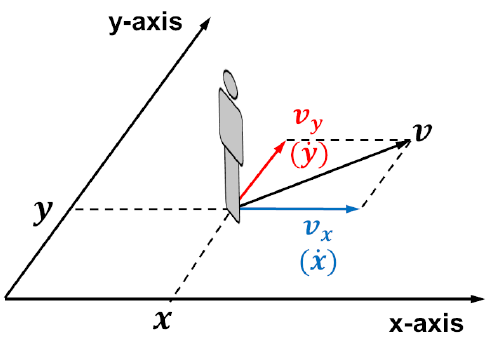
Figure 2. State variables for constant-velocity (CV) motion